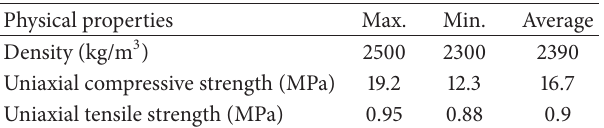
Table 1: Mechanical properties of Kufeki limestone used in the analysis [3].